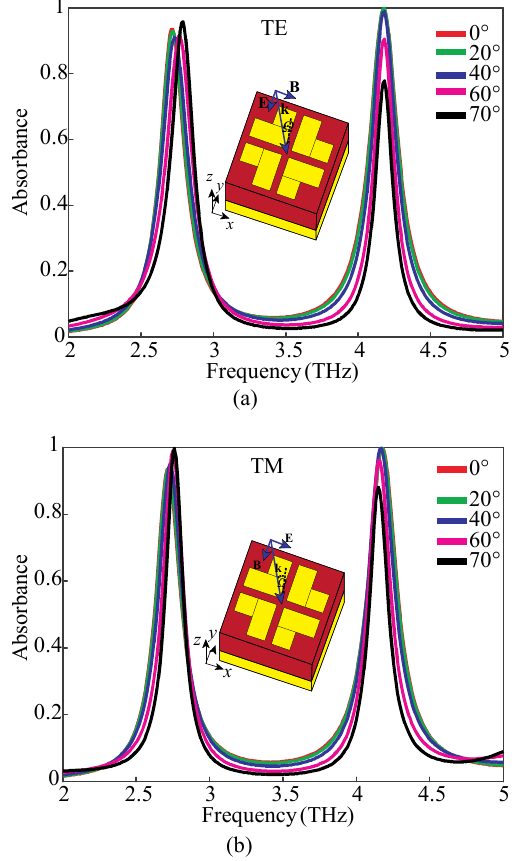
Fig. 5 Absorbance for an incidence range of angle 0° – 70°. In Fig. 5(a), absorbance is plotted for a TE mode of an incidence EM wave, and in Fig. 5(b), absorbance is plotted for a TM mode. In both cases, the incidence field E is demonstrated inside the